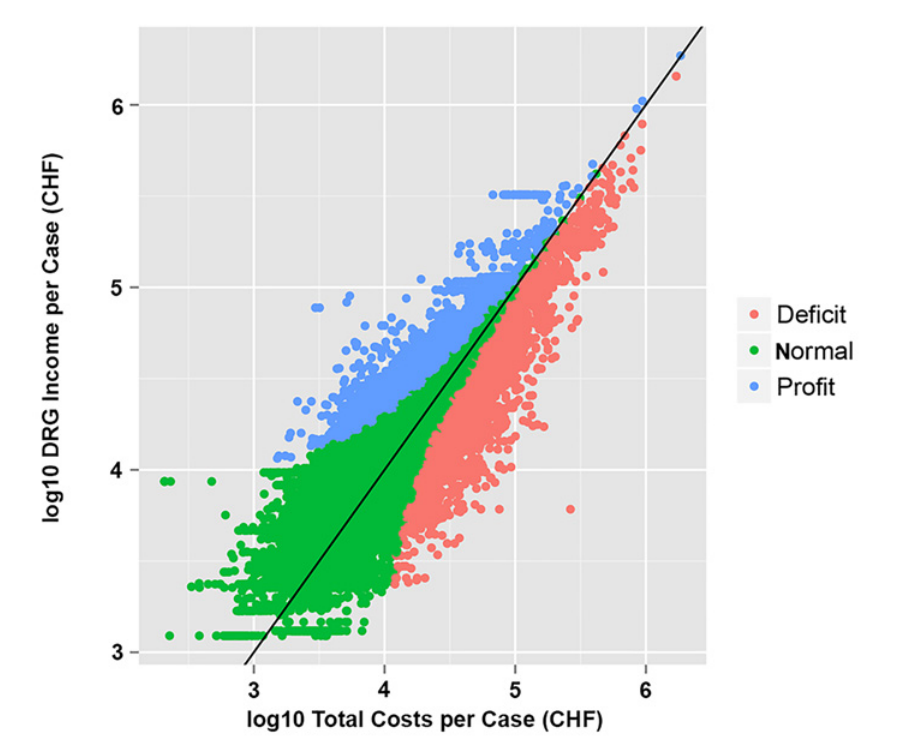
Fig 1. Outlier cases defined for IQR definition (n =